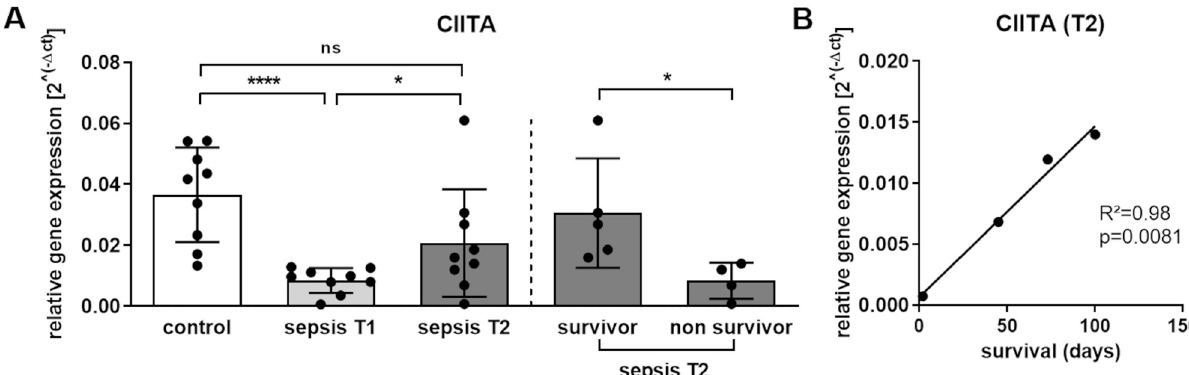
Fig 6. Expression of transcriptional co-activator CIITA gene, time course of sepsis-associated alterations and survival. (A) RNA from isolated human CD14 ++ monocytes was used for reverse transcription and subsequent qPCR using TaqMan Assay against CIITA . Relative CIITA expression was compared between control patients and patients with sepsis at the time of sepsis diagnosis (T1) and 7 days thereafter (T2). In the sepsis cohort, four patients died within one year (non-survivors); CIITA gene expression in these patients was further compared with CIITA expression in survivors at T2 (p < 0.0001, Mann-Whitney U test, control patients n = 9, patients with n = 9, survivors n = 5, non-survivors n = 4, mean ± SEM). (B) Correlations between relative expression values of CIITA gene 7 days after study inclusion (T2) and the number of surviving days in patients who died within one year after sepsis diagnosis were analyzed (R 2 = 0.98, p = 0.0081).